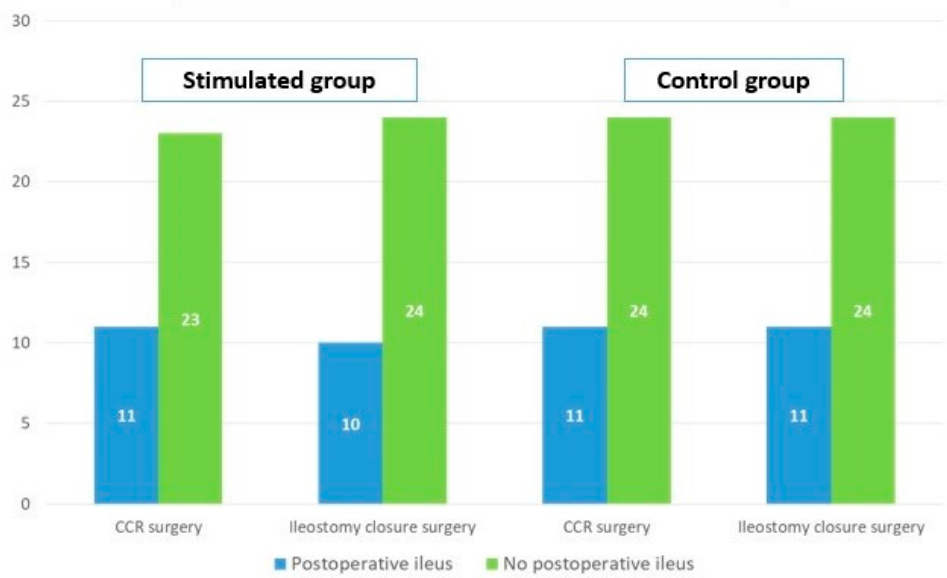
Figure 2. Comparison of postoperative ileus and the need for a nasogastric tube (NT) in colorectal surgery (CCR) and after reconstructive surgery.